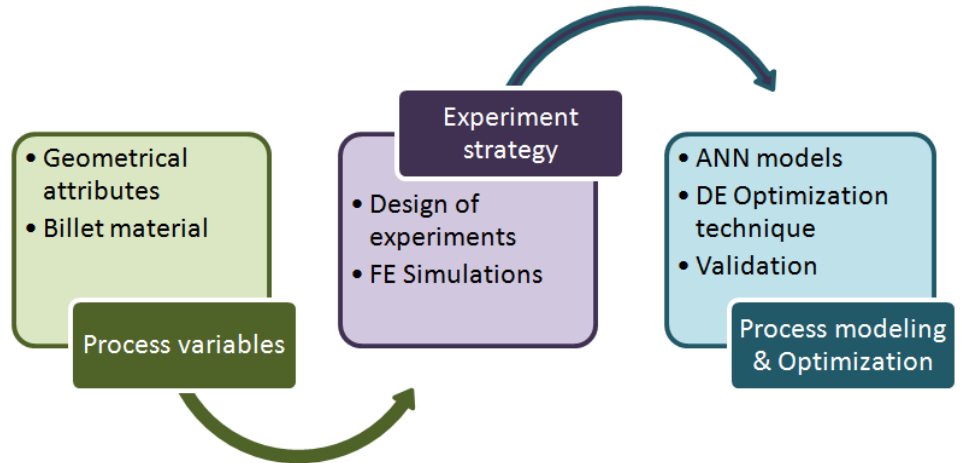
Figure 1. The research approach for the current investigation.